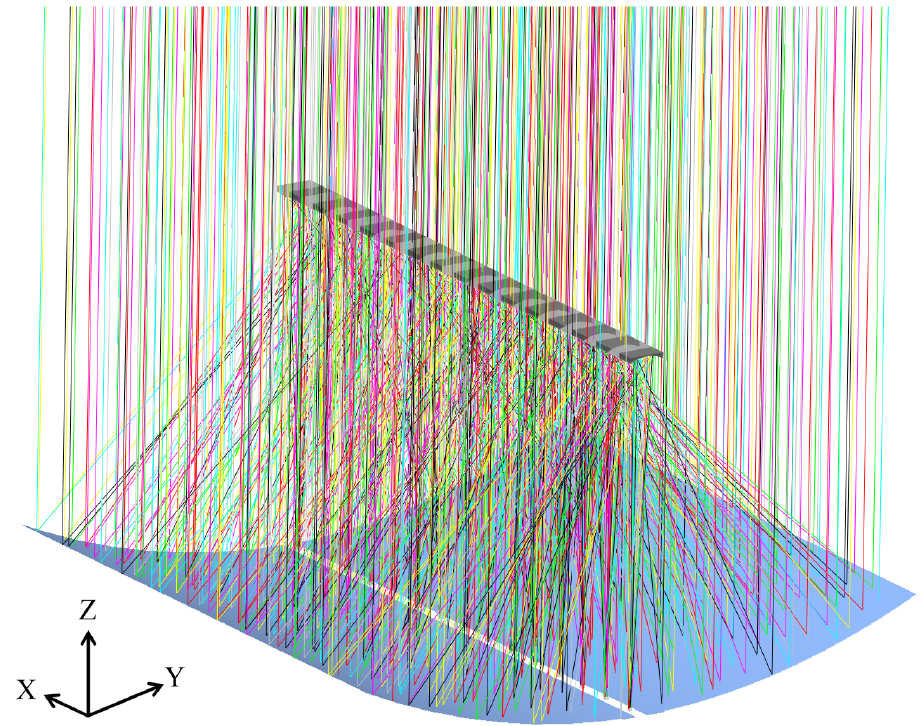
Figure 8. Showing simulation using full spectrum wavelengths.